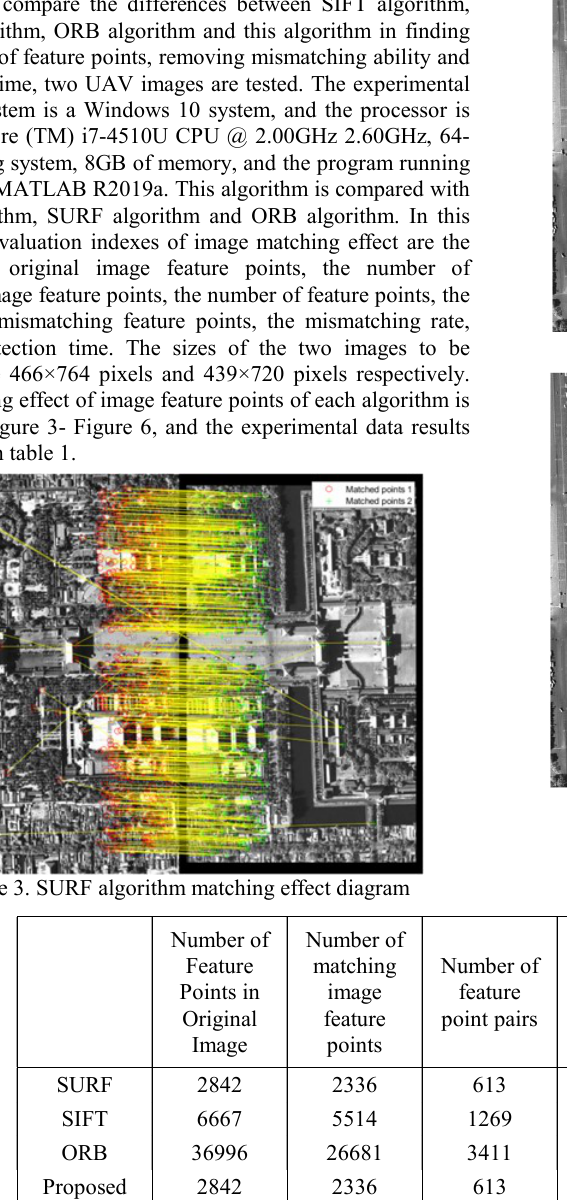
Figure 4. SIFT algorithm matching effect diagram